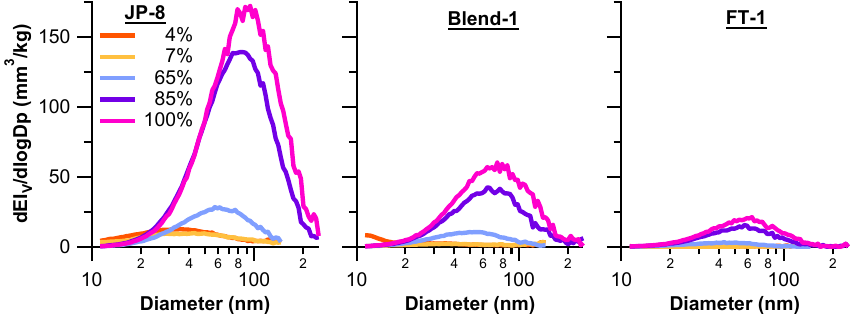
Fig. 4. Volume-weighted size distributions at 1m behind the exhaust plane for JP-8, Blend-1, and FT-1 (size distributions for Blend-2 and FT-2 are similar). Data are solely from the #3 engine.